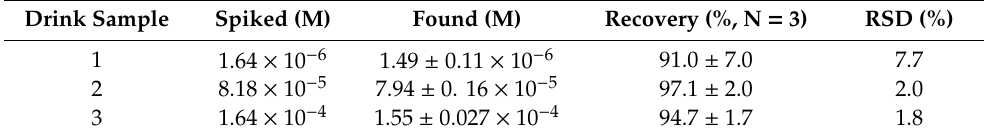
Table 2. Percentage recoveries and RSD of the detection of New Red spiked in a sports drink (mean ± SD, N = 3).